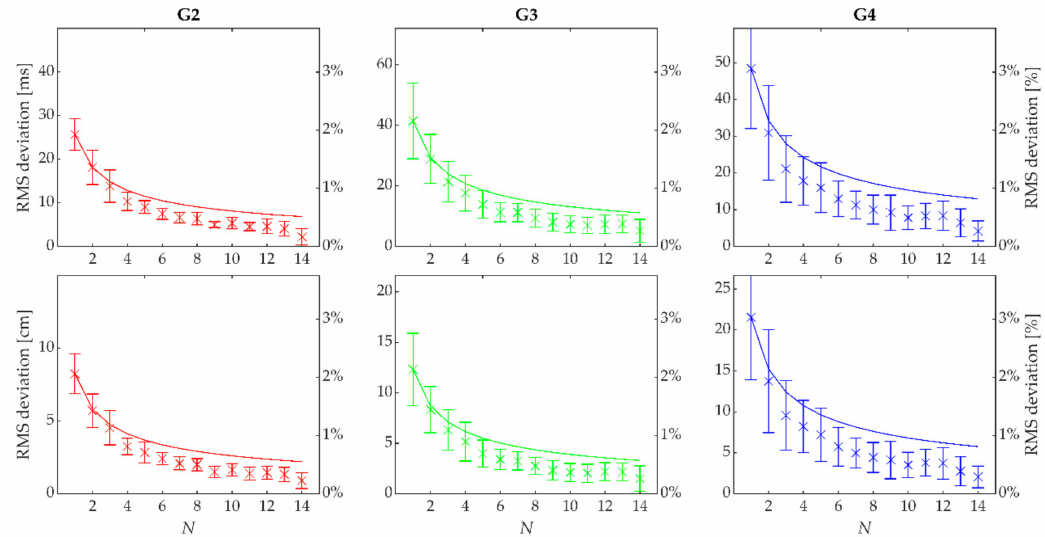
Figure 6. Root Mean Square (RMS) deviations between cycle duration (top row) and cycle length (bottom row) calculated using the head’s trajectory only and the criterion method (pole plants and CoM displacement), plotted as a function of the number N of successive cycles’ distance and time were averaged over (from 1 to 14 cycles). G2 is given in the left column, G3 in the middle column and G4 in the right column. The deviations are plotted in absolute values on the left y -axis (unequal scaling between time and distance plots) and relative values on the right y -axis (equal scaling between sub-techniques). The dotted lines indicate a function proportional to N − 1/2 , which would be expected when averaging over statistically independent